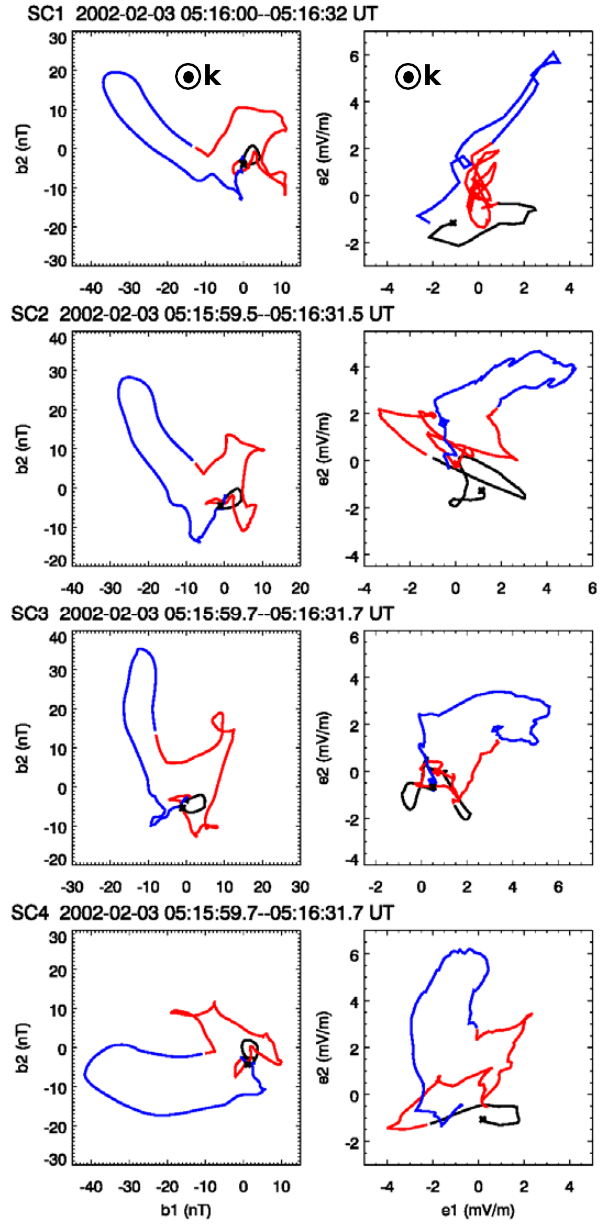
Fig. 3a. Hodogram for the interval A. Left panels: polarization of the magnetic waves observed at four Cluster spacecraft. Right panels: polarization of the electric waves. The k vector is pointing out of the paper.